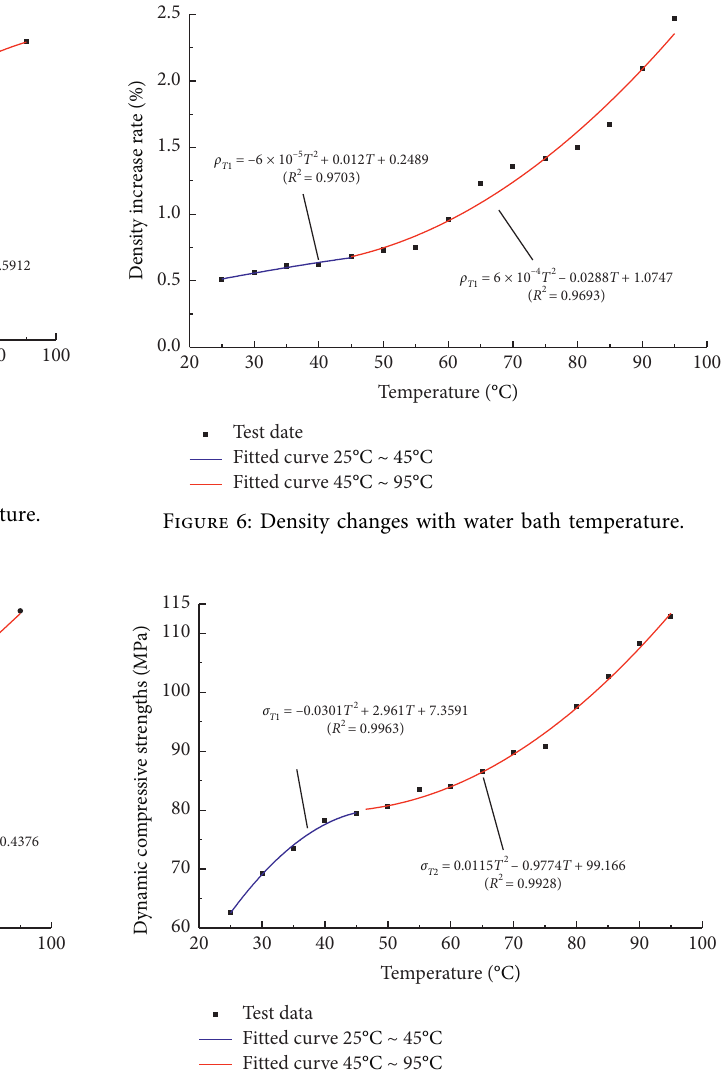
Figure 7: Fitting curve between water bath temperature and peak stress strength.